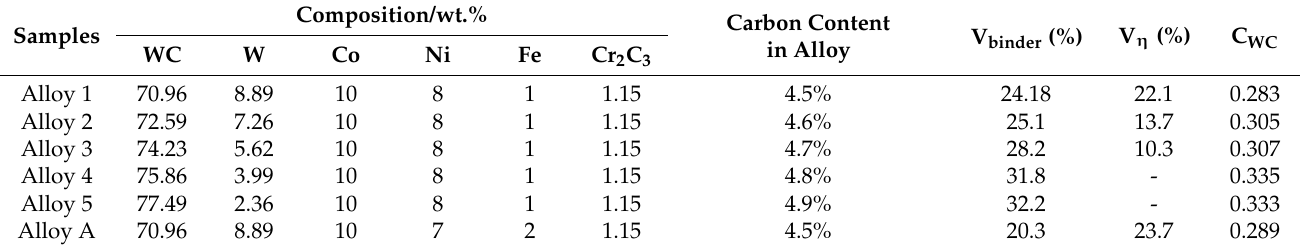
Table 1. Nominal composition, binder volume fraction (V binder ), volume fraction of η phase (V η ) and contiguity of the carbide phase (C WC ) of WC-CoNiFeCr and WC-Co. Samples